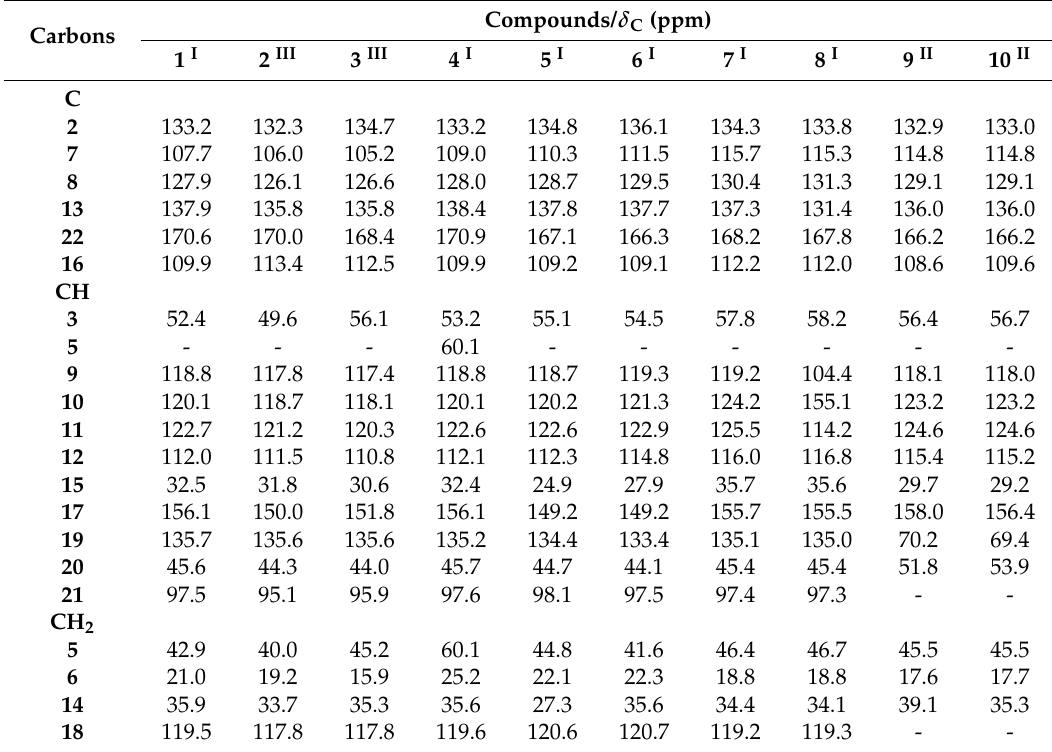
Figure 2. Structural signaling based on specific signals compared with values for strictosidine ( 1 ): absence of a given signal in red and presence in green. Table 2. 13 C-NMR data of MIAs from Psychotria species.